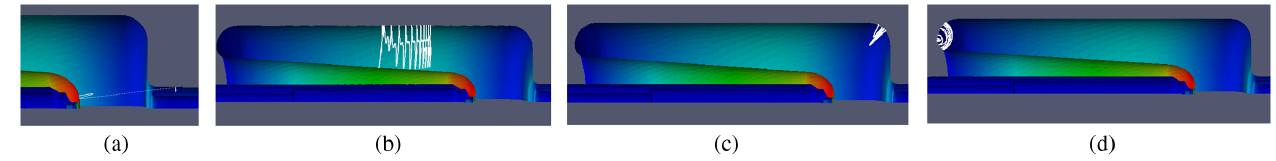
¼ 28 eV; (b) 8th i ¼ 500 eV); (d) 1st order i